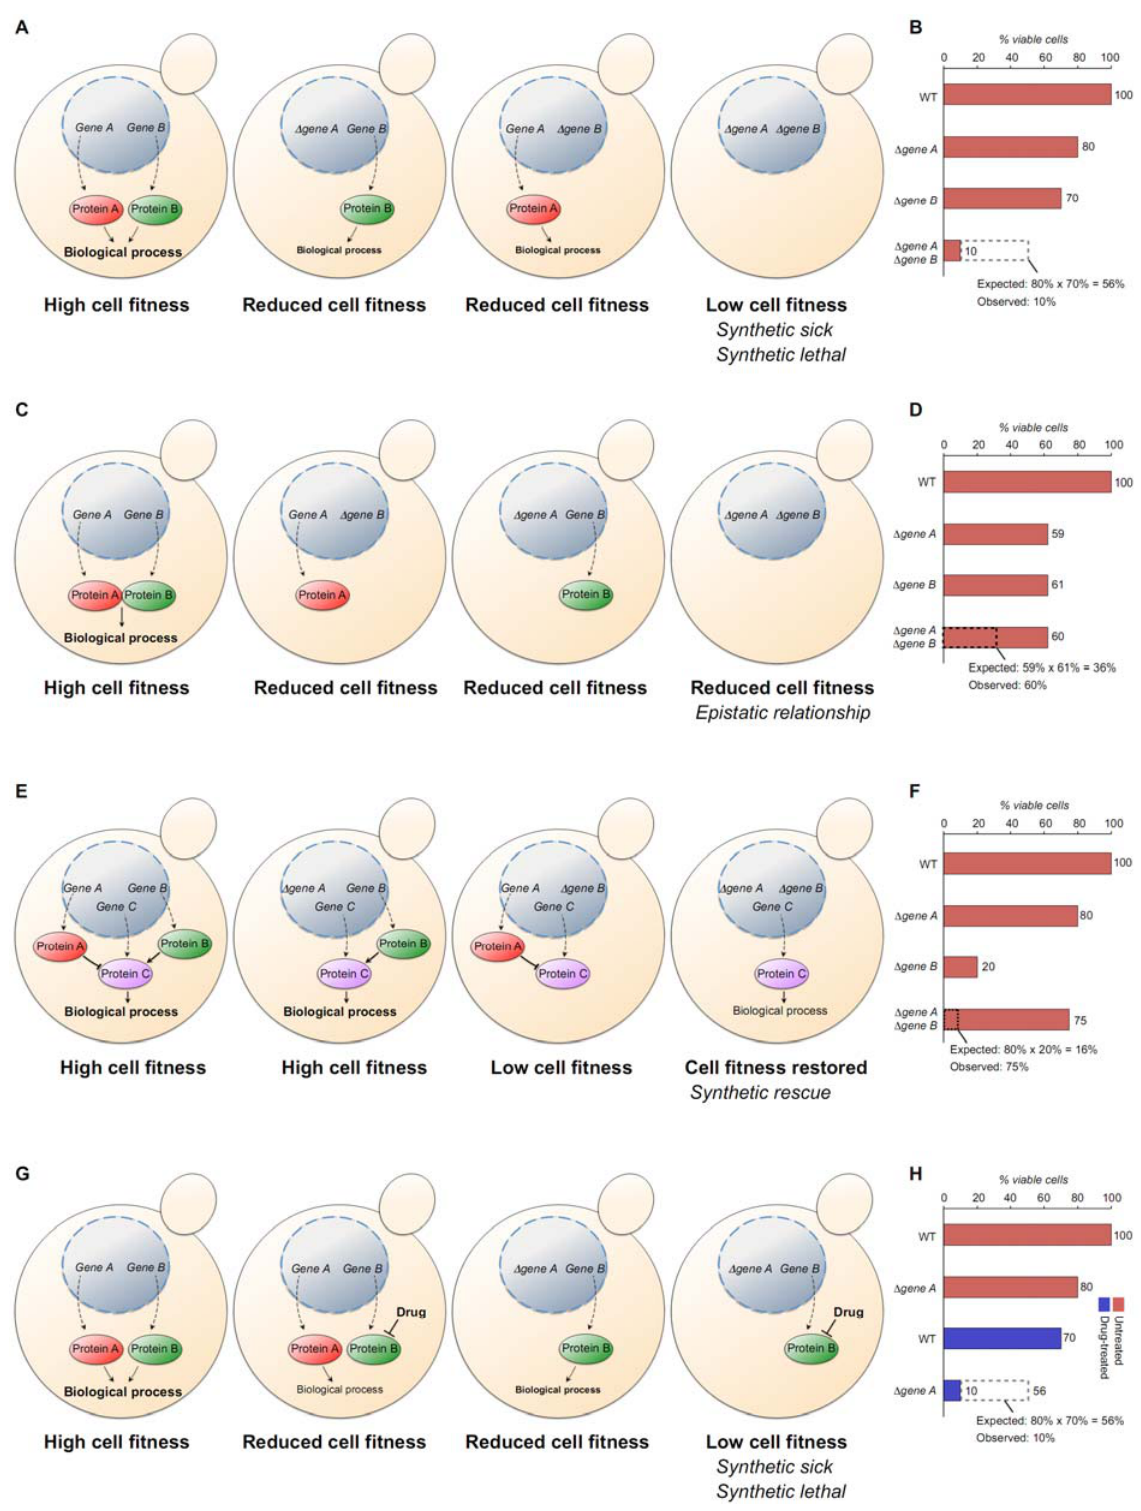
Figure 1. Defining different forms of genetic relationships between genes. ( A ) Negative genetic interaction; ( B ) Depiction of cell viability of the example shown in ( A ); ( C ) Epistatic genetic interaction; ( D ) Depiction of cell viability of the example shown in ( C ); ( E ) Positive genetic interaction; ( F ) Depiction of cell viability of the example shown in ( E ); ( G ) Negative chemical-genetic interaction; ( H ) Depiction of cell viability of the example shown in ( G ). See text for